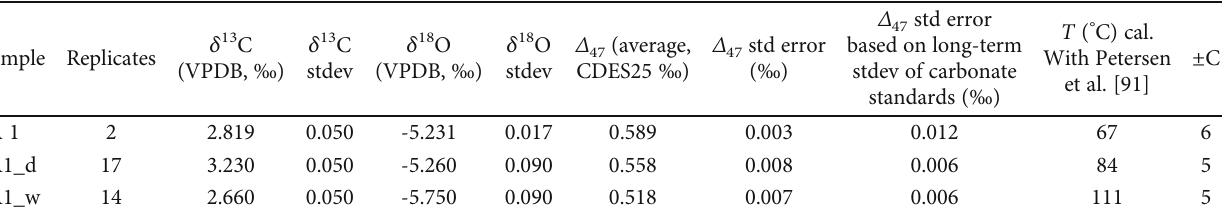
Figure 11: (a) Graph showing the distribution of stable isotope data for the analyzed samples. Blue rhombus refers to the PAM13 data; yellow square refers to the vein V1 data from PAM1 and ET3; the symbol “ x ” refers to the vein V2 from ET3; pale blue square refers to the vein V3 data from the PAM1 sample. (b) PAM1 isotope data distinguished on the basis of their mineralogy. See the good correlation ( R 2 = 0 : 8527 ) between stable isotopes of aragonite crystals. Table 5: Results of the clumped isotopes